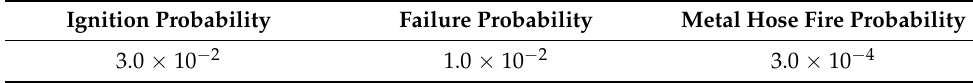
Table 5. Metal hose fire probability.